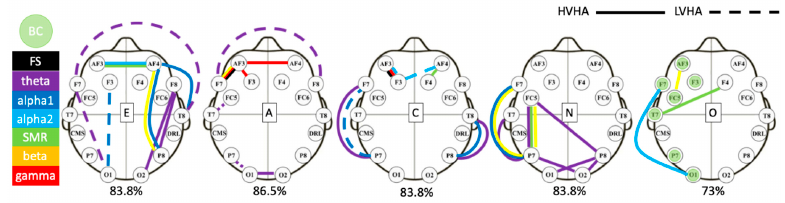
Figure 3. This figure demonstrates the 10 best features extracted from ReliefF algorithm for each dimension of personality as evaluated by the fusion scenario. Bivariate features are demonstrated by lines, whereas univariate features (here only betweenness centrality (BC)) are denoted by colored nodes. The color of each edge represents a specific brainwave (black is full spectrum (FS) from 4 to 45 Hz), while the maximum classification accuracy for each trait is written beneath the head plots. Finally, the solid lines denote features extracted from HVHA clips, while dashed lines denote features extracted by LVHA